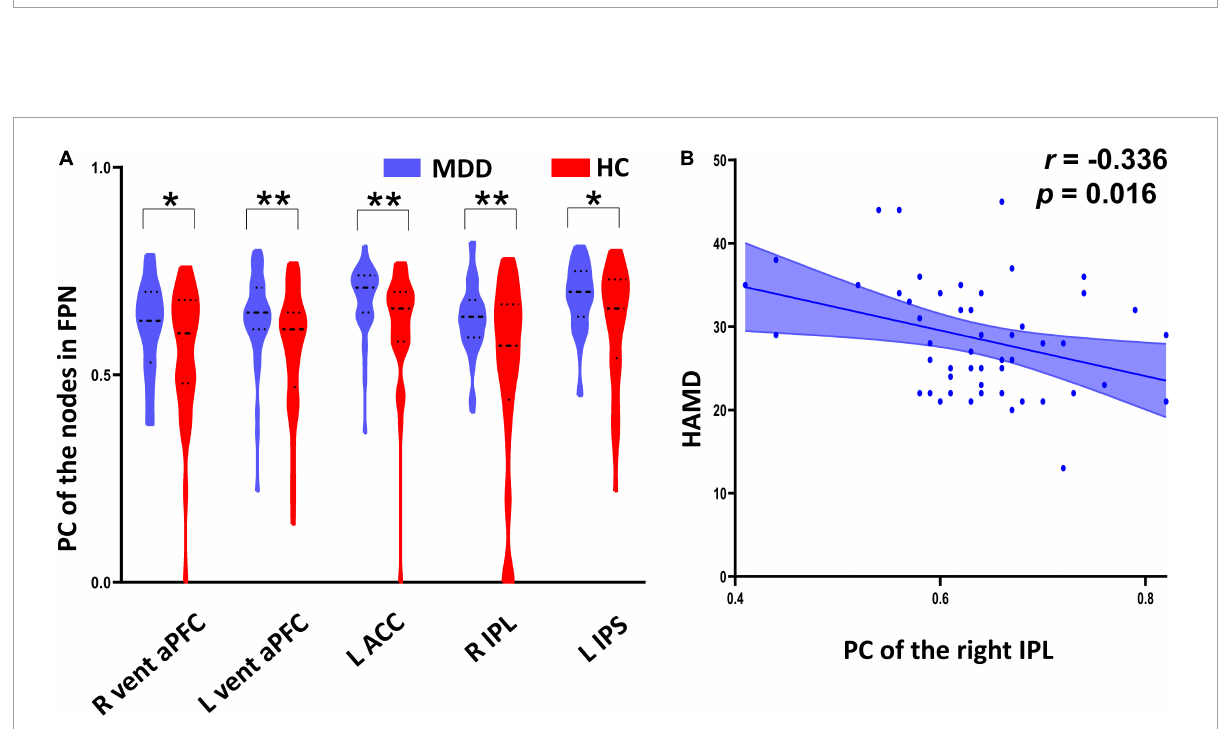
FIGURE4 Between-group differences of participation coefficient (PC) of the nodes in frontal–parietal network (FPN) and their correlation with HAMD scores. (A) The major depressive disorder (MDD) patients exhibited significantly increased PC in the bilateral ventral anterior prefrontal cortex, left anterior cingulate cortex, right inferior parietal lobule, and left intraparietal sulcus relative to the healthy controls (HC). (B) The PC values of the right inferior parietal lobule were significantly negatively correlated with HAMD scores in the MDD group. *Indicates p < 0.05, **indicates p <